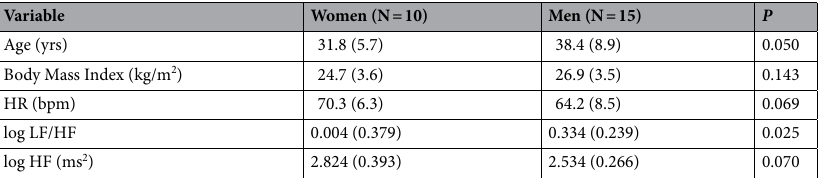
Table 1. General characteristics of the enrolled subjects at baseline. Note: mean (SD); HRV, heart rate variability; P values refer to unpaired Student’s t -tests comparing men and women.